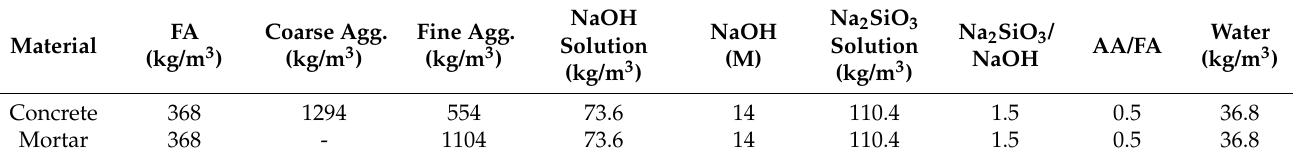
Table 3. Mix proportions of geopolymer concrete and